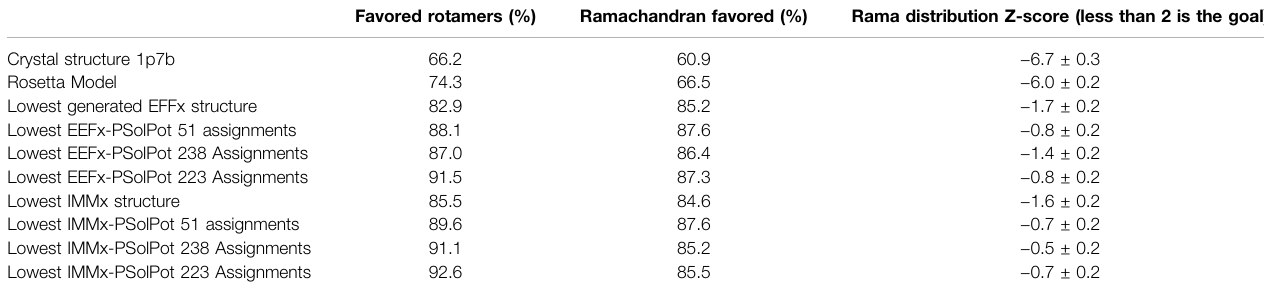
TABLE 3 | Comparison of structure quality performed on MolProbity for the generated structures to initial structures. Favored rotamers